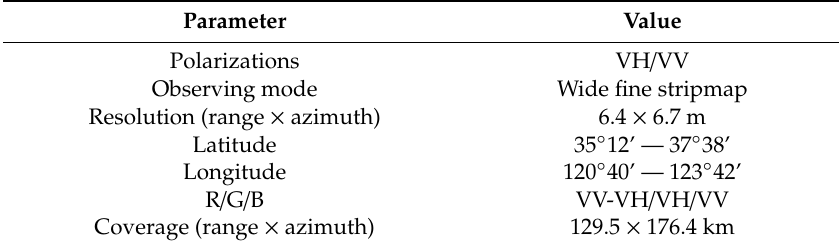
Figure 8. Pseudo-colored RGB image of GF3 ocean data under the low-sea state with R = | VV − VH | , G = | VH | and B = | VV | . Table 3. Detailed parameter of the low-sea state data.